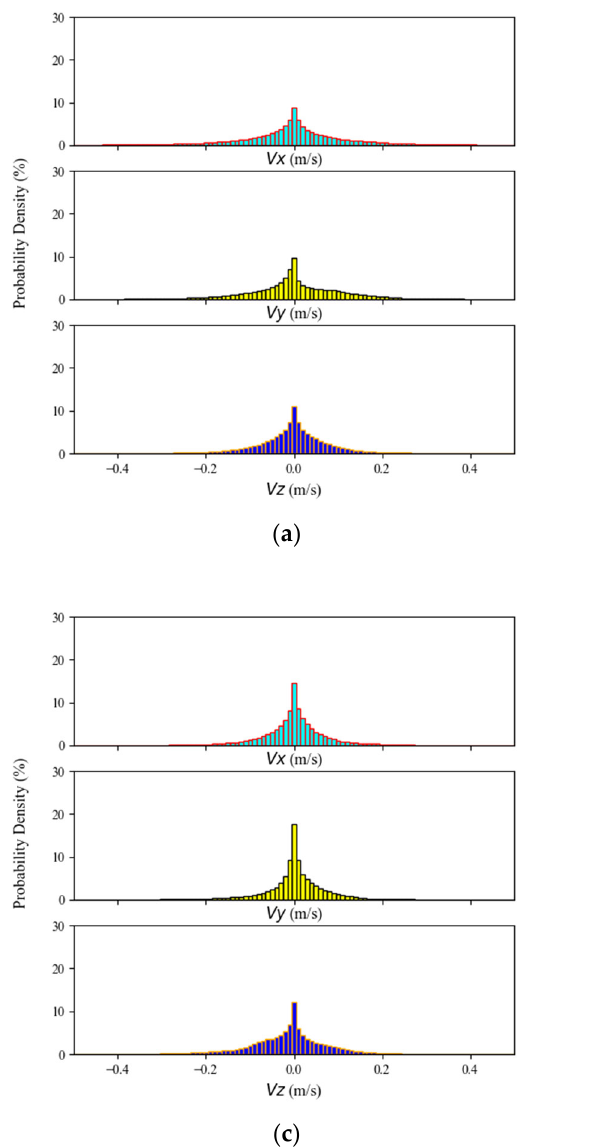
Figure 12. The probability density distributions of the x , y , and z ‐ axis velocity components at t = 30 s for paddle angle of ( a ) 0°, ( b ) 30°, ( c ) 45° and ( d ) 60°.